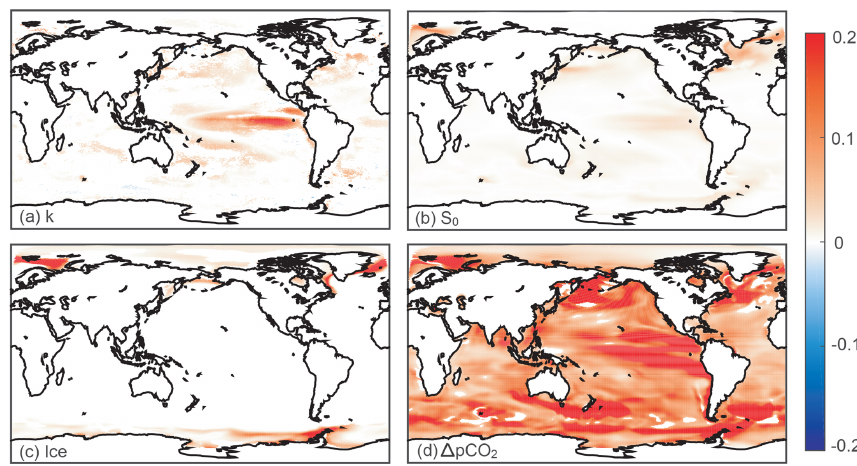
Figure 5. Drivers of predictability in air–sea CO 2 flux during forecast year 1, as indicated by the predictability of the (a) gas exchange coefficient, (b) solubility, (c) sea ice fraction, and (d) (cid:49)p CO 2 , scaled to CO 2 flux units (molm − 2 yr − 1 ). Correlation coefficients that are not statistically significant at the 95% level using a t test are assigned a value of zero.